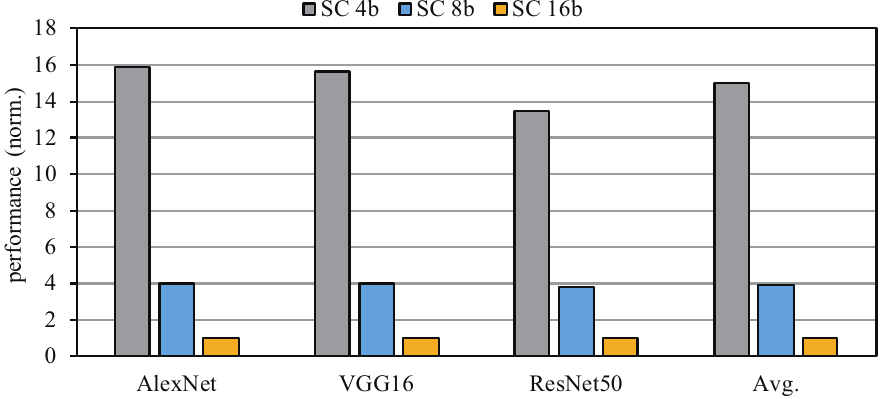
Figure 16. Performance comparison for different bit widths with different